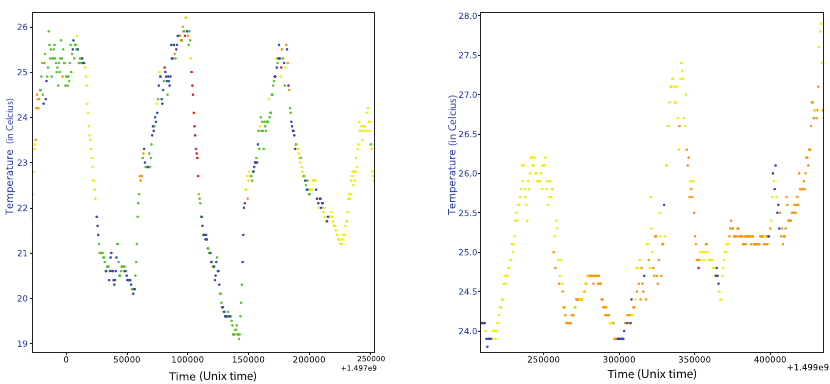
Figure 5. The temperatures for two different days and the correlation with the wind direction. The direction of the wind is represented by the different dot colors with blue to be a North–South direction and with red a West–East direction. On the left we have a couple of days at the middle of the measurement period and on the right a couple of days at the end of the measurement period.